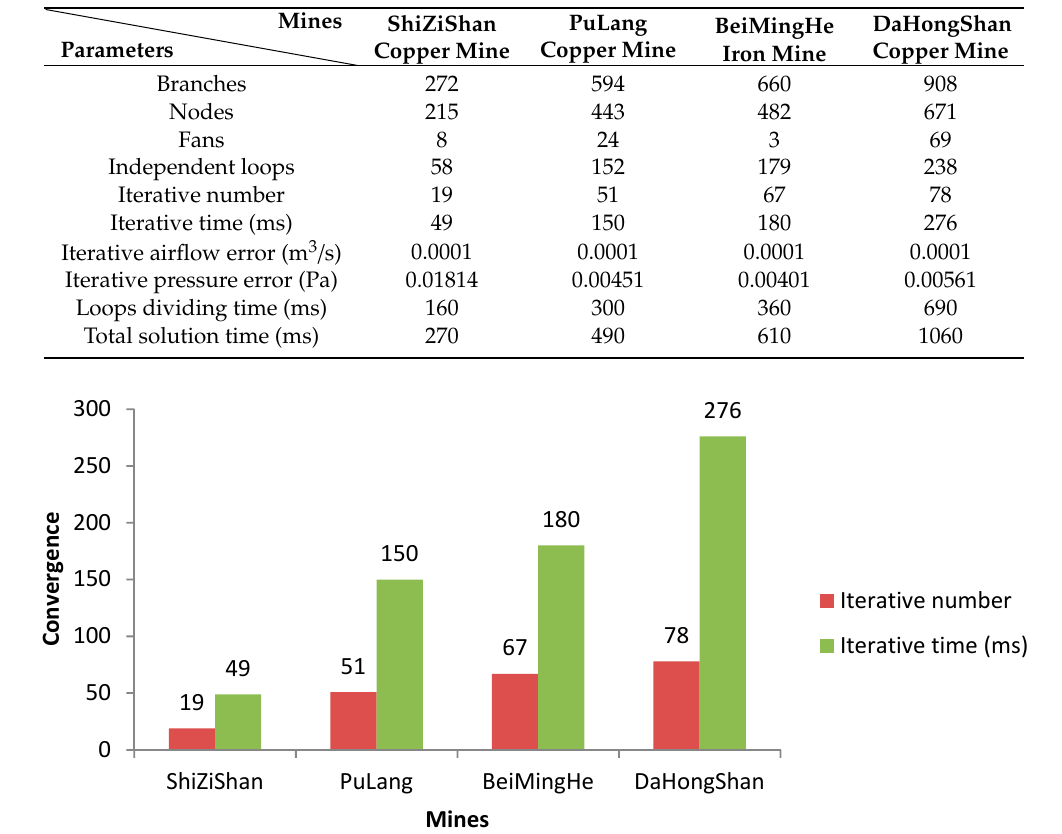
Figure 8. The ventilation network models of four actual mines. ( a ) ShiZiShan Copper Mine; ( b ) PuLang Copper Mine; ( c ) BeiMingHe Iron Mine; ( d ) DaHongShan Copper Mine. Table 1. Solution results of four actual mines, including the network and convergence parameters.